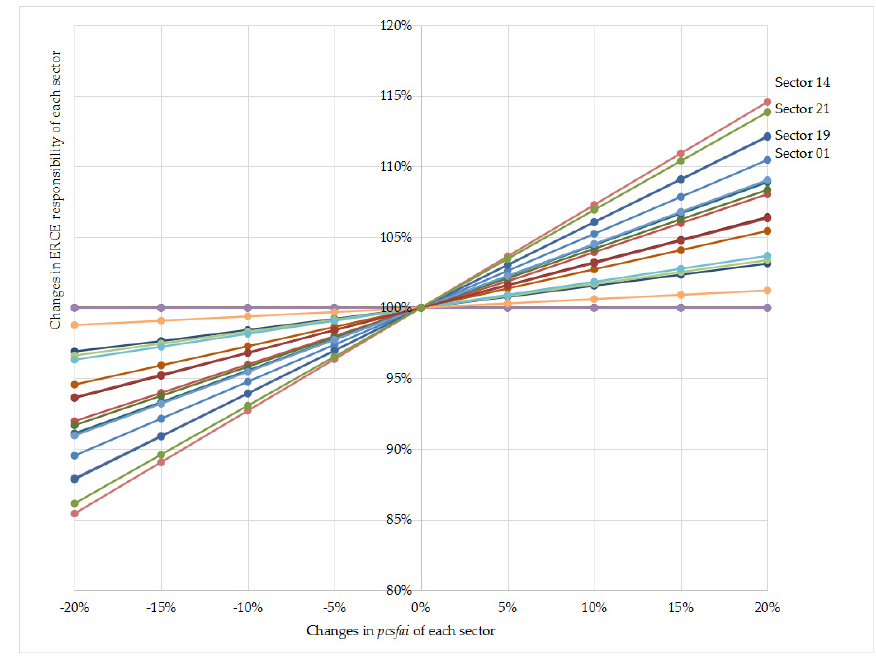
Figure 6. Sensitivity analysis of pcsfai t .